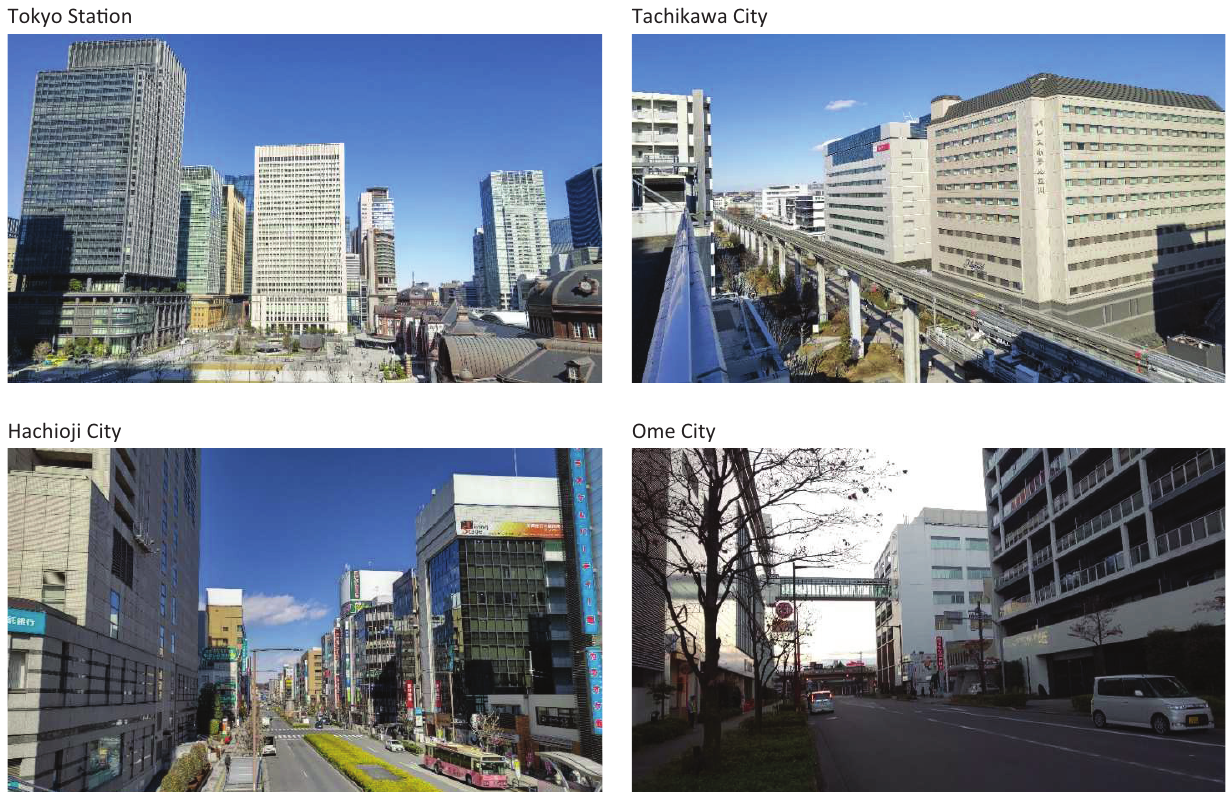
Figure 2. Tokyo Station and Tachikawa, Hachioji, and Ome Cities as BCCs facing political and administrative